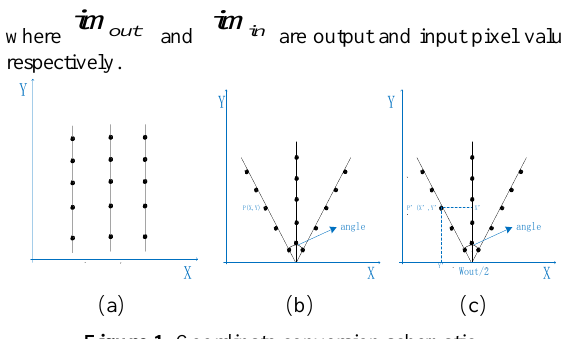
Figure 1 . Coordinate conversion schematic.